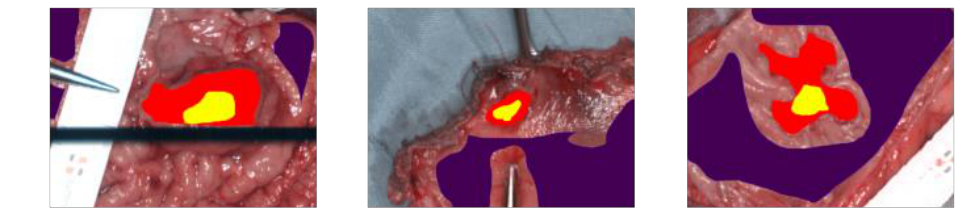
Figure 1. Examples of masks with ground truth labels, where purple is non-malignant tissue, yellow is cancerous, and red is margin of cancerous tissue.